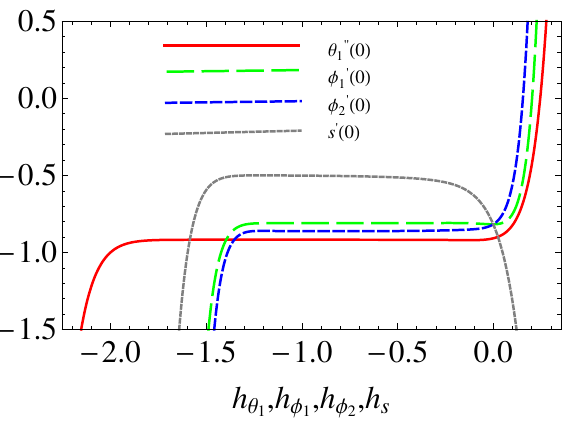
Figure 2. h -curve for f (cid:48)(cid:48) ( 0 ) , θ (cid:48) ( 0 ) , φ (cid:48) ( 0 ) and s (cid:48) ( 0 ) . The convergence value is tabulated in Table 1 for different orders of approximations. ( 0 ) , − φ (cid:48) ( 0 ) , − φ (cid:48) ( 0 ) and − s (cid:48) ( 0 ) for γ = 0.1, M = 0.2, Rd = 0.1, Table 1. Convergence of the series − θ (cid:48)(cid:48) 2 1 1 θ w = 0.1, Pr = 1.4, Nt = 0.1, Nb = 0.1, D f = 0.2, Sc n = 1.9, Sc = 0.4, C r = 0.1, A = 0.1, S r = 0.2, G 1 = G 2 = G 3 = 0.1 and B 1 = B 2 = B 3 = 0.1. m -th Order